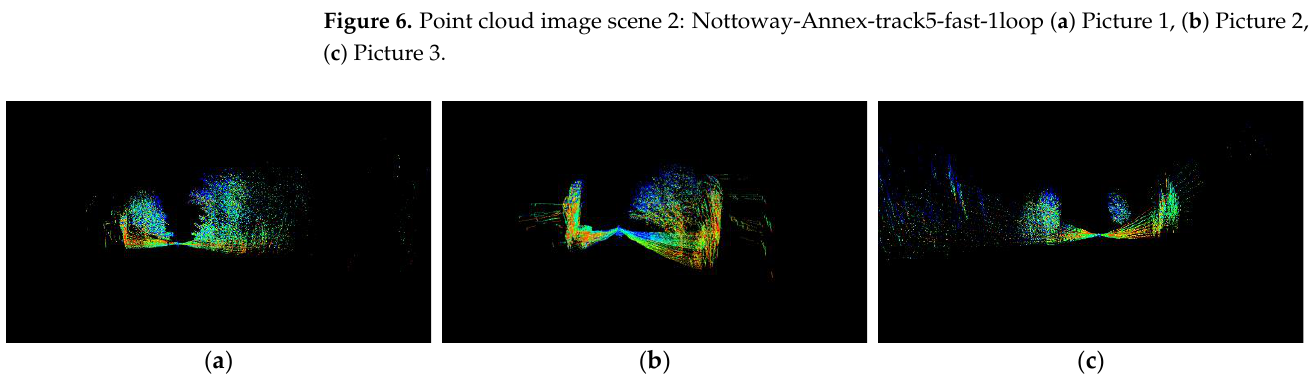
Figure 8. Point cloud image scene 4: Shenandoah-4-fast ( a ) Picture 1, ( b ) Picture 2, ( c ) Picture 3. ( a ) ( b ) ( c ) Figure 9. Point cloud image scene 5: Heating-S16 ( a ) Picture 1, ( b ) Picture 2, ( c ) Picture 3. ( a ) ( b ) ( c ) Figure 10. Point cloud image scene 6: Masonvale ( a ) Picture 1, ( b ) Picture 2, ( c ) Picture 3.